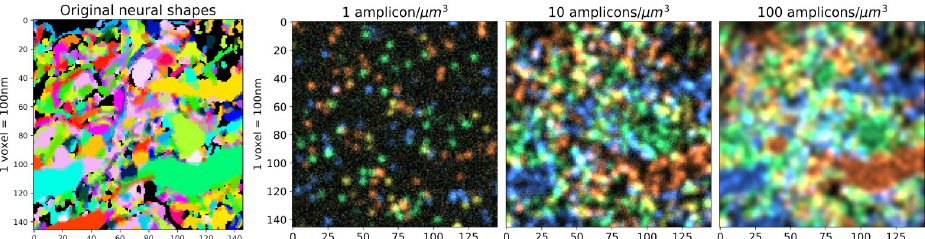
Fig 3. High-resolution, dense-expression simulation with varying amplicon densities. Left : 2D slice of the original neuronal shapes; each neuron is visualized with a different random color. Partial overlapping due to point-spread blur can be seen from the mixing of the colors on the boundary of the neurons. Right : Corresponding slice of the simulated imagestack, considering several different density values. Note that the imagestack colors do not correspond to the neuronal visualization colors on the left; the imagestack colors arise from their corresponding barcodes. A video showing multiple z-planes can be found at this link.